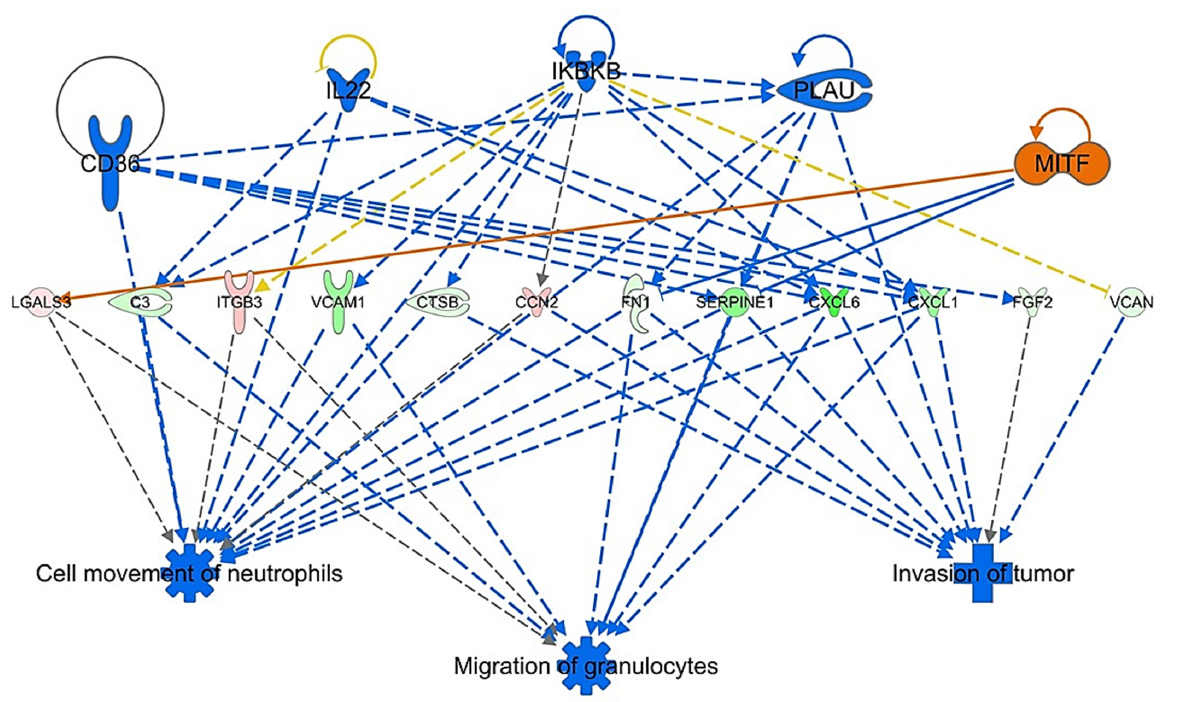
Figure 7. Top IPA Regulator E ff ect analysis network obtained after the integration of predicted upstream regulator results together with downstream e ff ects to generate a causal hypothesis. There is predicted inhibition of four regulators including CD36, IL22, IKBK, and PLAU, whereas MITF is predicted to be activated in Caki-2 cells but not Caki-1 cells. The overall e ff ect is predicted to inhibit the invasion of the tumor, cell moment of neutrophils, and migration of granulocytes.